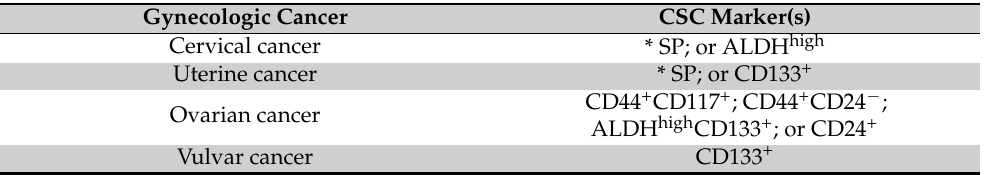
Table 3. Cancer Stem Cells reported in gynecologic cancers